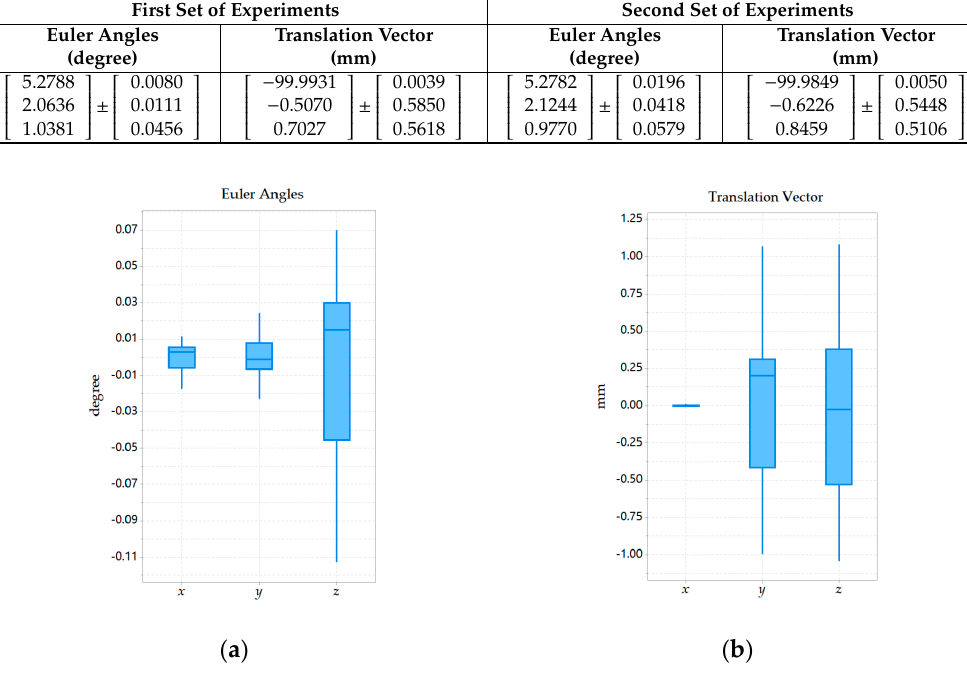
Figure 14. Box plot of the Euler angles and translation vector minus the mean in the first set of experiments: ( a ) Distribution of Euler angles; ( b ) Distribution of translation vector.